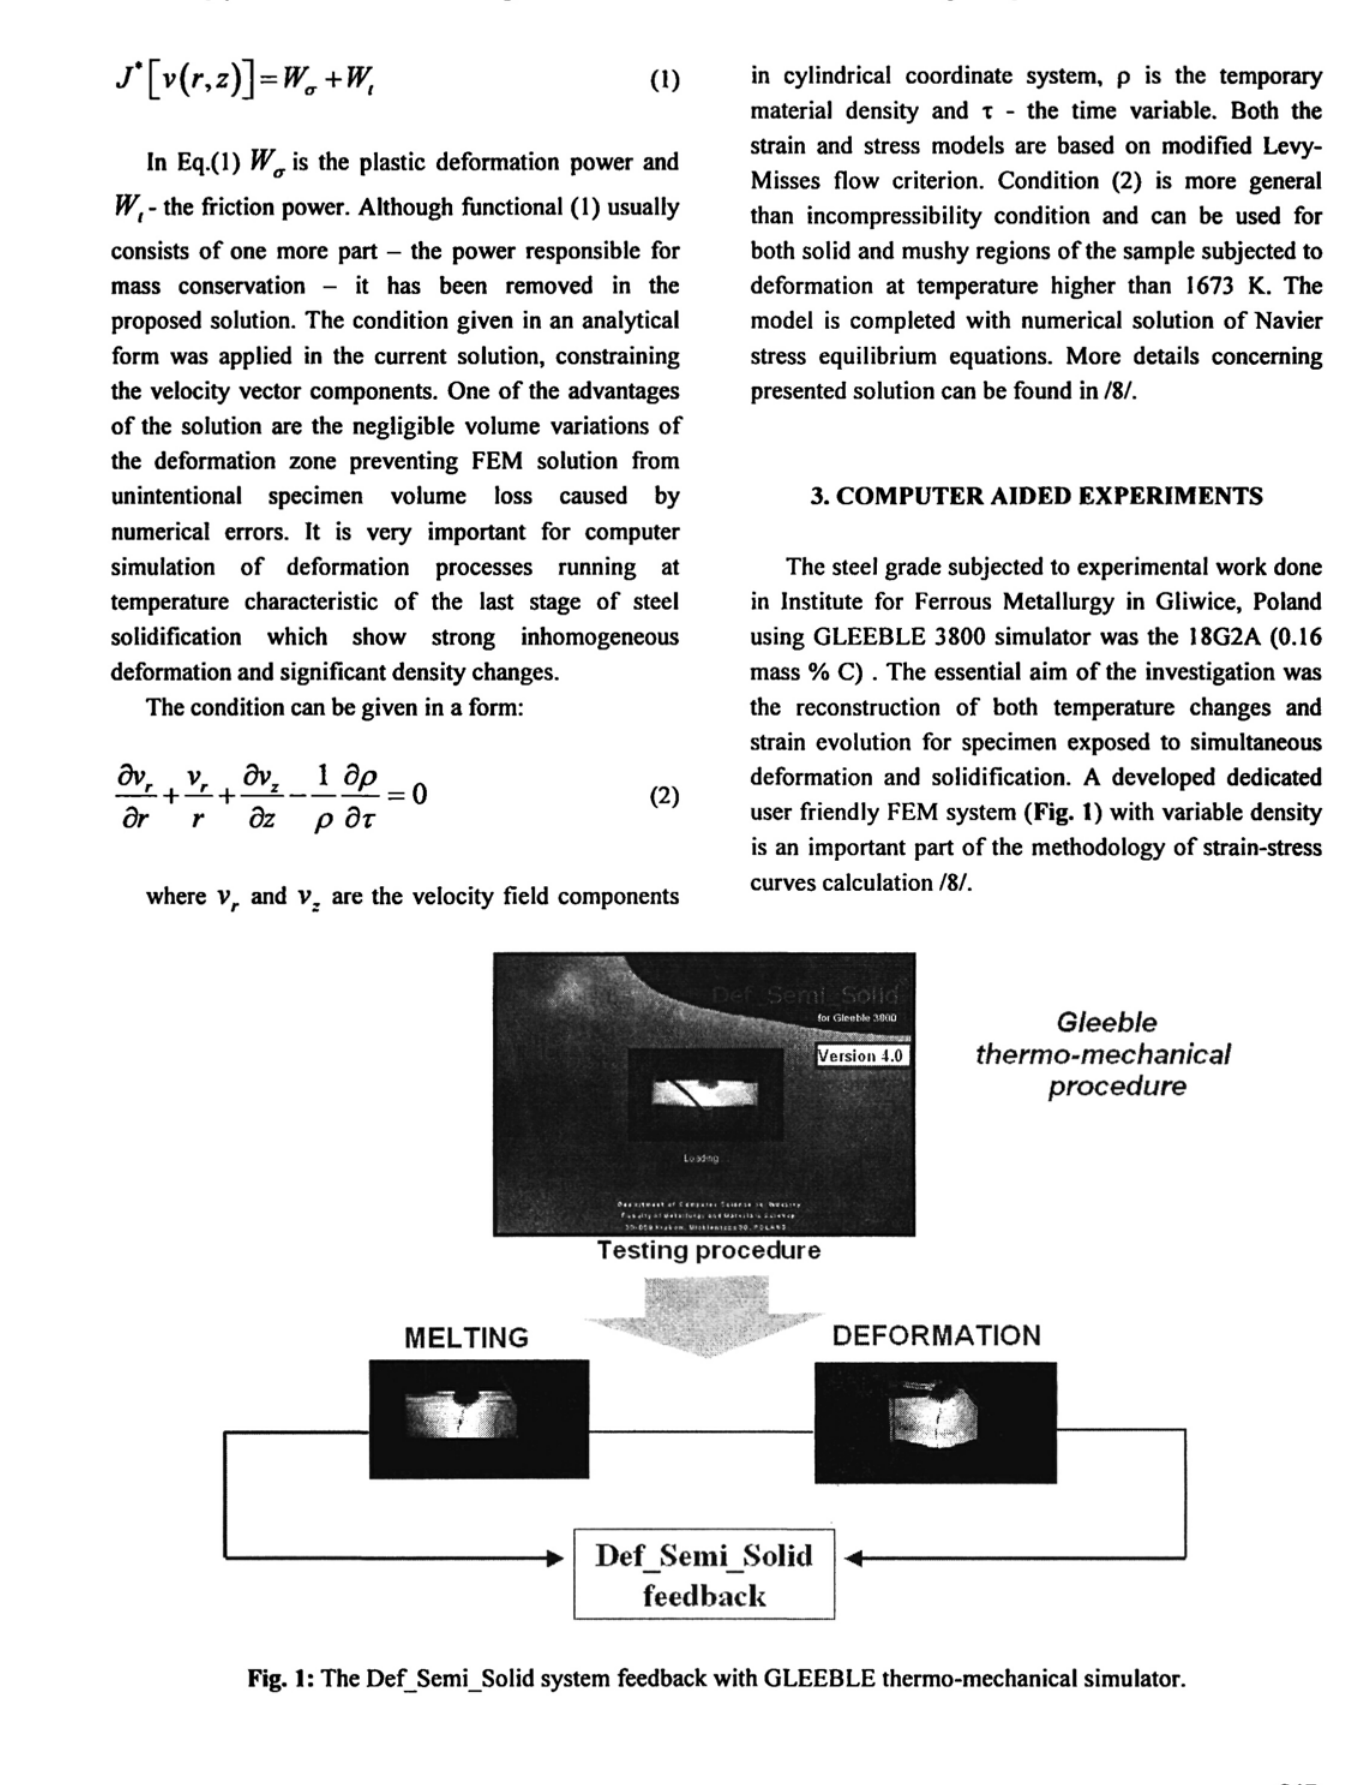
Fig. 1: The Def_Semi_Solid system feedback with GLEEBLE thermo-mechanical